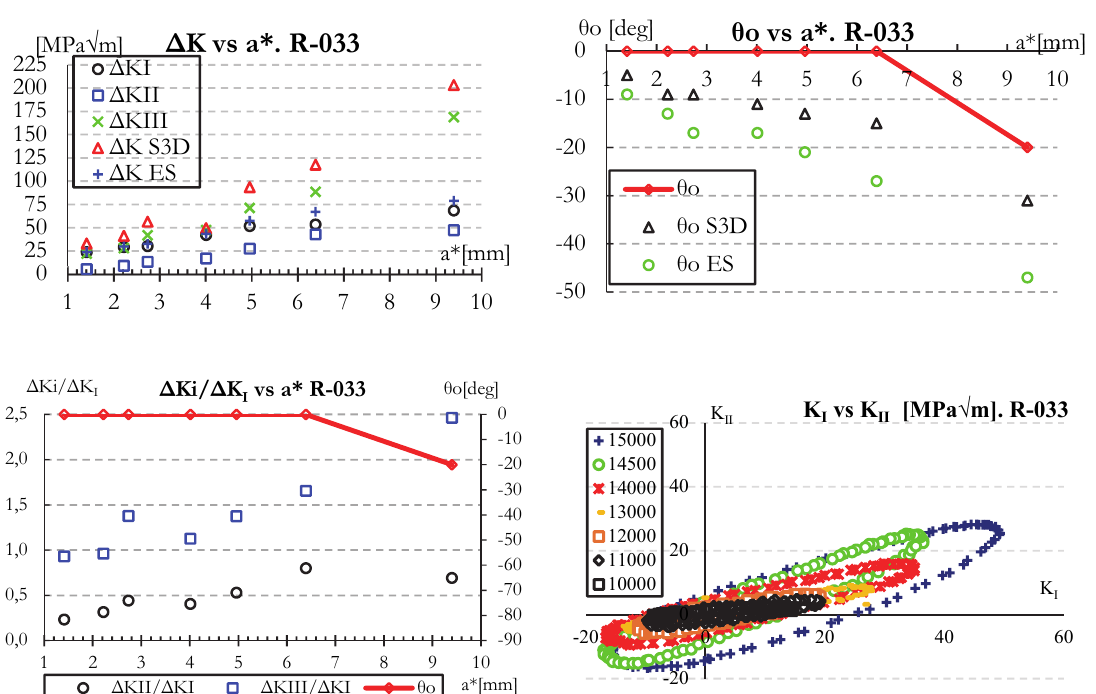
Figure 8: Crack tip parameters measured and calculated for specimen R-033, phase shift 45° between tension 33kN and torsion 382Nm